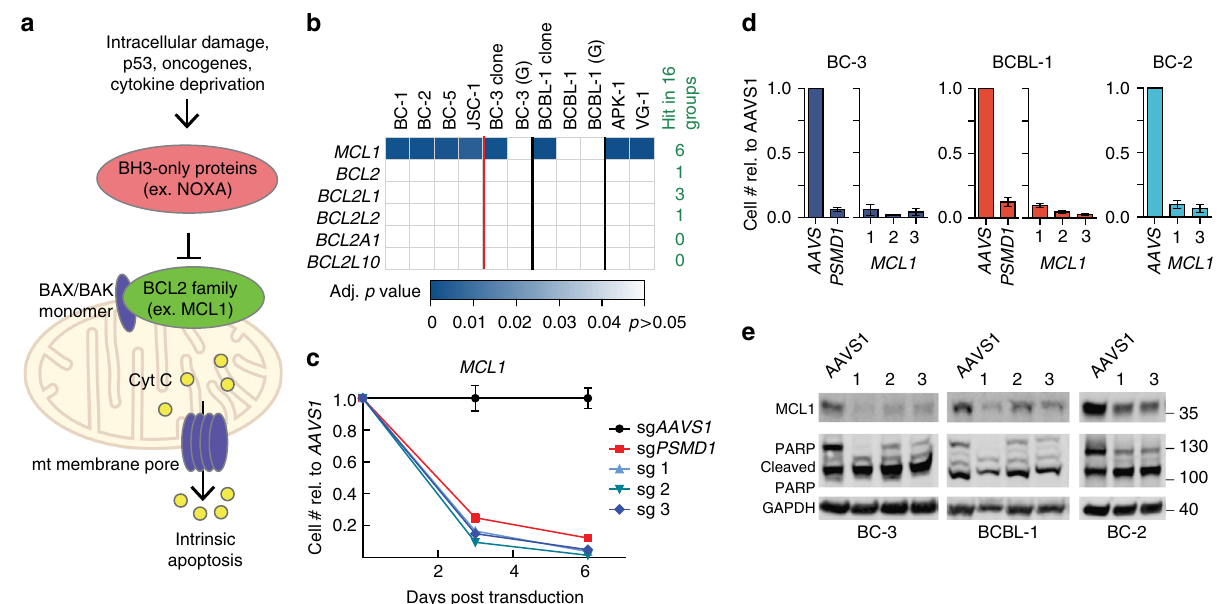
Fig. 5 PEL cell lines are addicted to MCL1. a BCL2 family proteins primarily function on the outside of the mitochondrial membrane to prevent BAX or BAK monomers from oligomerizing to form outer membrane pores. Upon intracellular stress, pro-apoptotic BH3-only proteins are upregulated and bind to the BCL2 proteins, thereby competing with BAX or BAK. The free BAX or BAK monomers then oligomerize to form outer mitochondrial membrane pores, resulting in cytochrome c to the cytosol and initiation of apoptosis. b Heatmap of adj. p values of sgRNA depletion of the BCL2 family genes across screens. Indicated on the right are the numbers of cancer types (out of 16) where the gene was found to be potentially essential. The Brunello library was used for most of the screens except where indicated: G, GeCKO v2. c Representative growth curve analysis following MCL1 knockout in BC-3 Cas9 ( n = 3, technical replicates). d End-point analysis of several growth curves for MCL1 knockout in BC-3, BCBL-1, or BC-2 Cas9 cells ( n = 3, biological